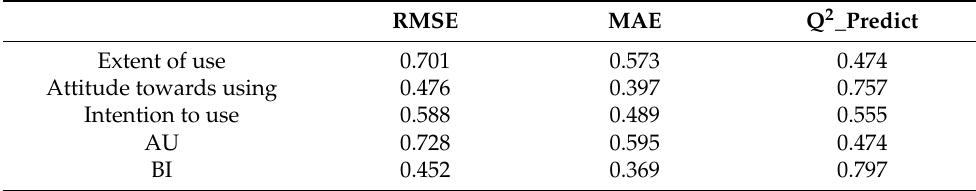
Table 7. Predictive performance for the PLS paths